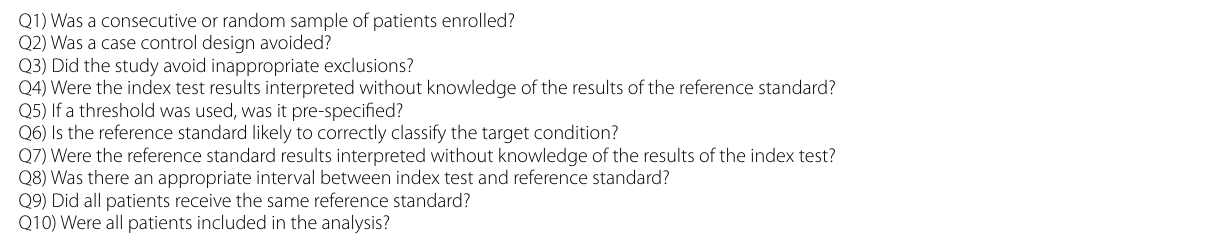
Table 3 Criteria for quality assessment of accuracy studies (The Joanna Briggs Institute